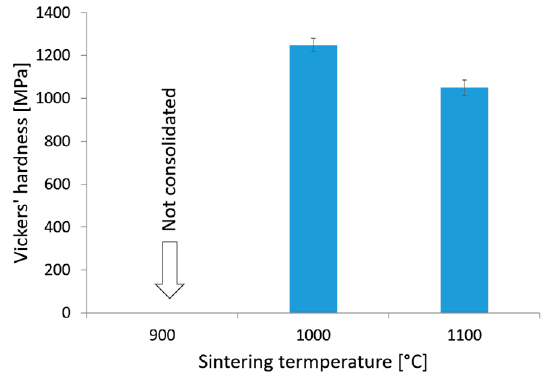
Figure 6. Average of the Vickers’ hardness on the ceramic phase of the TCP–Fe composite sintered at temperatures of 1000 and 1100 ◦ C. No consolidation of the composite at the temperature of 900 ◦ C leads to the brittle fracture of the sample during indentation, giving no